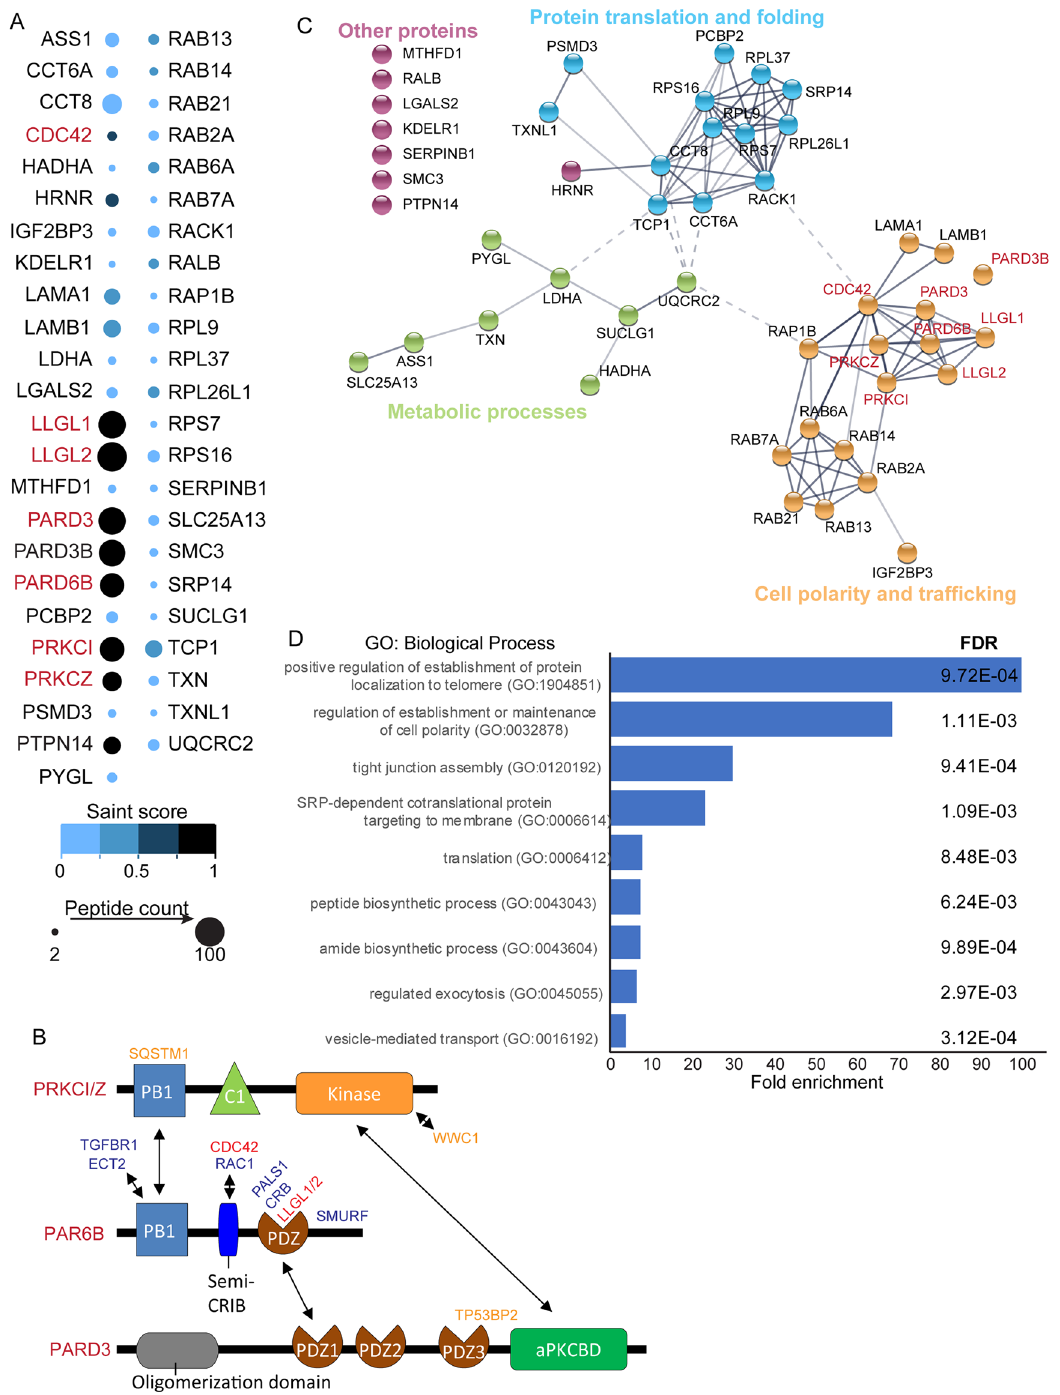
Figure 3. Identification of PAR6B proximity proteins in polarized Caco-2 cysts. ( A ) The SAINT score (dot color) and peptide counts (dot sizes) for PAR6B-proximity proteins identified in 3D BirA*-PAR6B-expressing Caco-2 cells are shown. Proteins known to associate with the apical Par complex are shown in red. ( B ) Diagram shows known interaction domains and interactors for Par complex (aPKC, PAR6B, PARD3). Proteins in red are known interactors for PAR6B and were identified in BirA*-PAR6B mass spectrometry data. Proteins in blue are known interactors for PAR6B and were not identified in BirA*-PAR6B mass spectrometry data. Proteins in orange represent interactors of aPKC or PARD3 that are not known to interact with PAR6B that were identified as proximal to BirA*-PAR6B. ( C ) Diagram showing connections between PAR6B-proximal proteins based on data from the STRING database (version v11.5, https:// string- db. org/). Line darkness indicates the strength of the predicted relationship between the proteins. ( D ) Graph shows fold enrichment of different biological processes of for PAR6B proximal proteins based on the Gene Ontology database (version, 10.5281/ zenodo.1205166) 44–46 . FDR: False Discovery